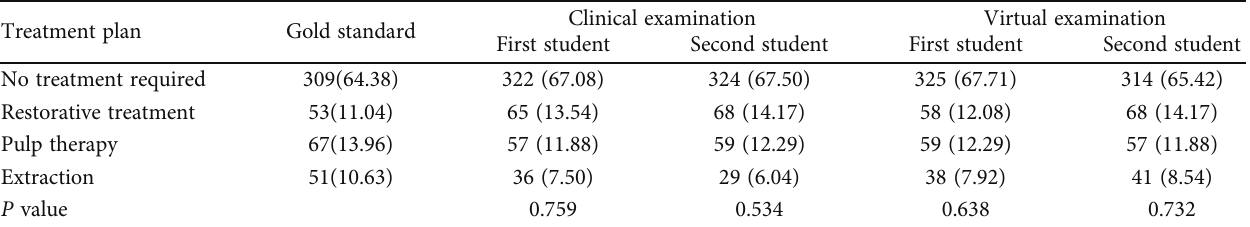
Table 3: Frequency distribution of treatment plans presented by the examiners in virtual and clinical examinations. Treatment plan